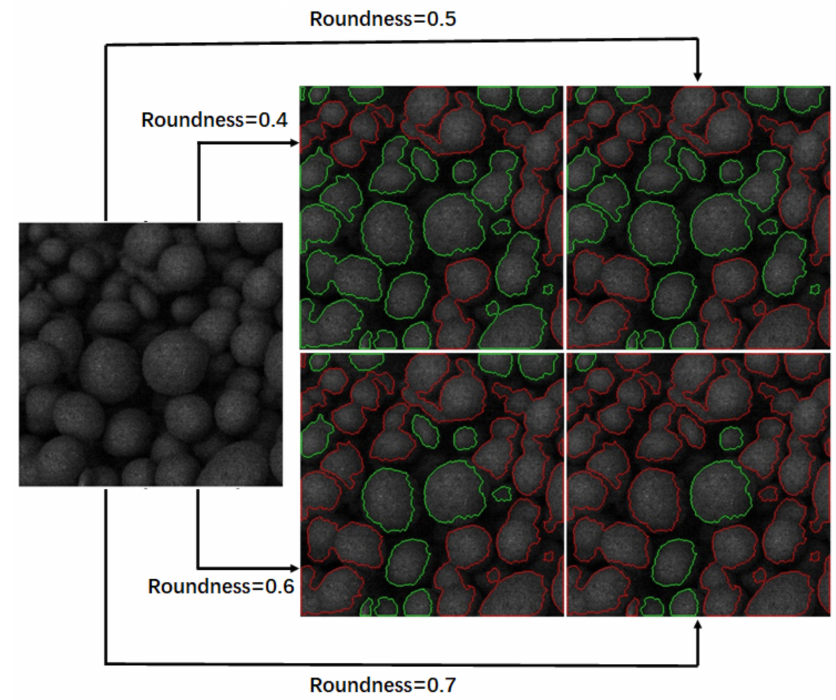
Figure 5. Screening results of different roundness